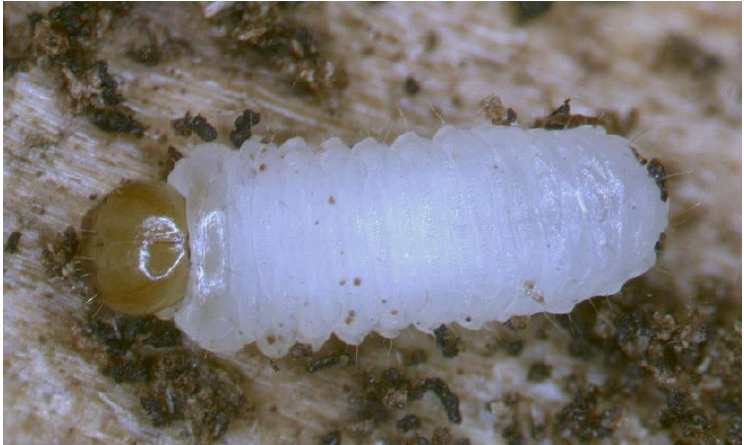
Figure 2. Euryommatus mariae live larva photographed in a gallery under a Leica stereoscopic microscope, length 3.8 mm.